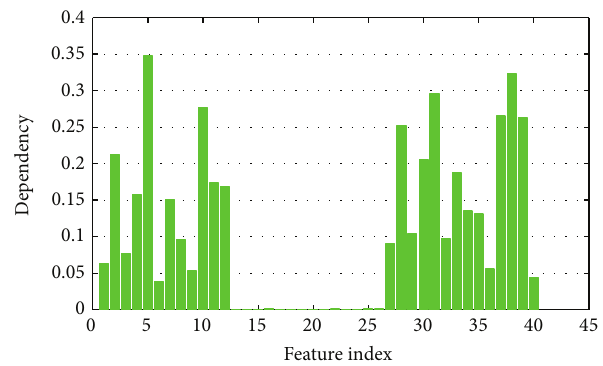
Figure 10: Fuzzy dependency between a single feature and decision.